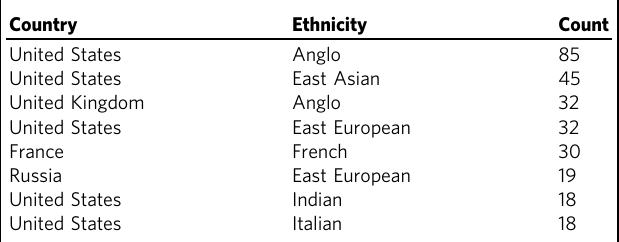
Table 2 Inferred lingo-ethnic and country pairings of elite mathematicians from 1990 to the